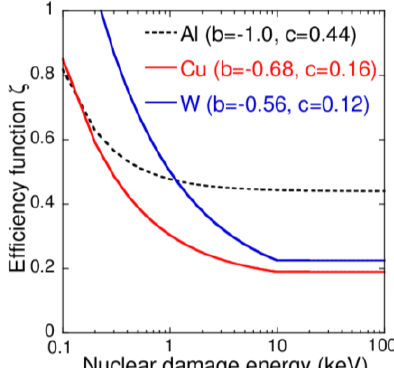
Figure 3 . Defect production efficiency of aluminium, copper and